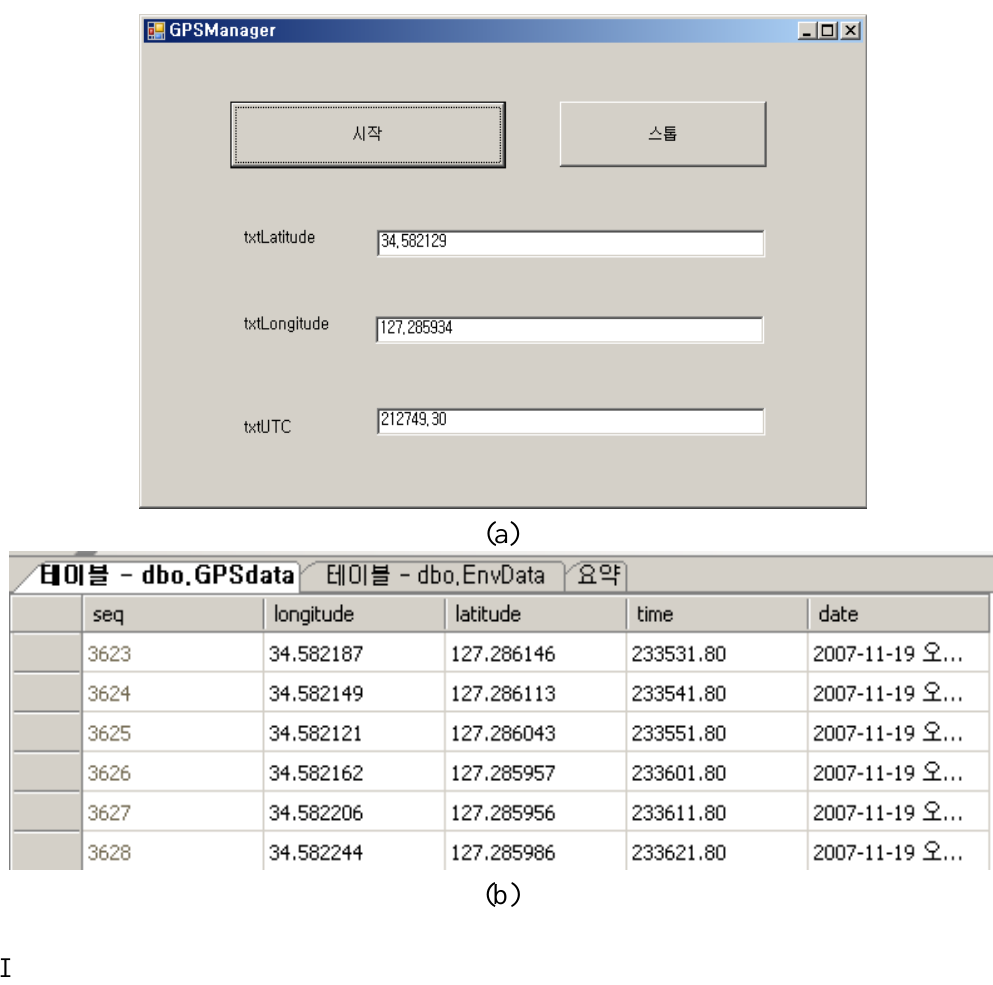
Figure 17. GPS Manager and GPS Information Table. (a) GPS Manager; (b) Location Information